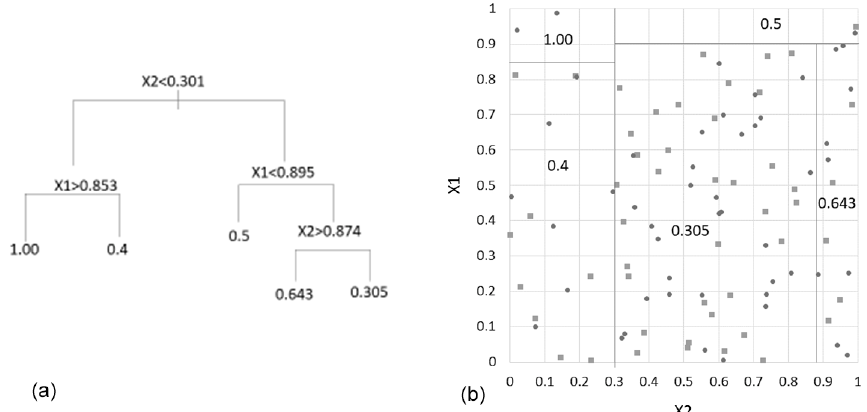
Figure 1. Visual representation of a generic, two-variable decision tree regression problem (a) and its mapping onto a parameter space for the independent variables (b)